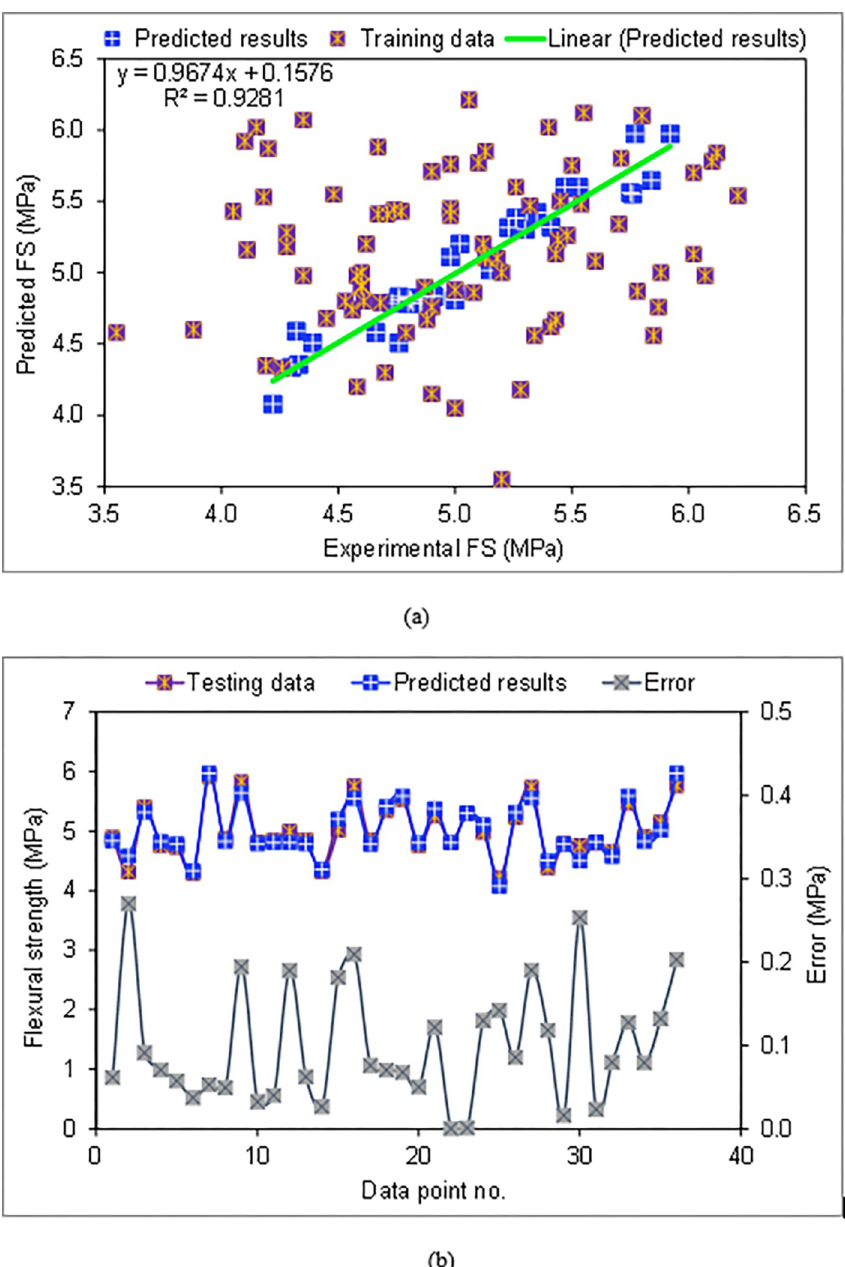
Fig 10. BR model: (a) Correlation among actual and estimated FS; (b) Dispersion of actual, estimated and error results.